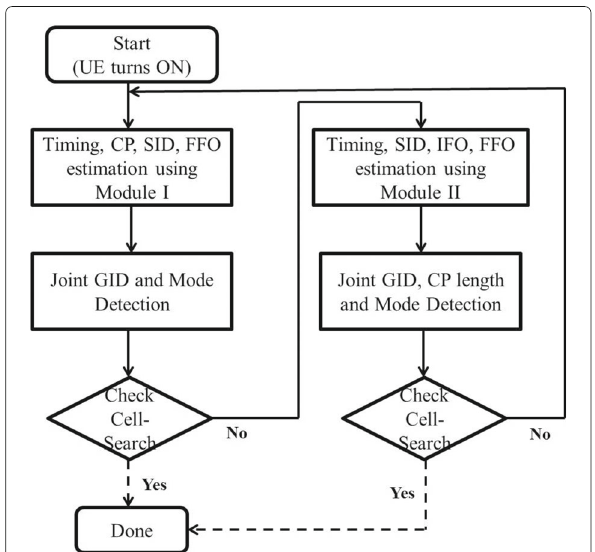
Fig. 1 Flow chart of the proposed cell search